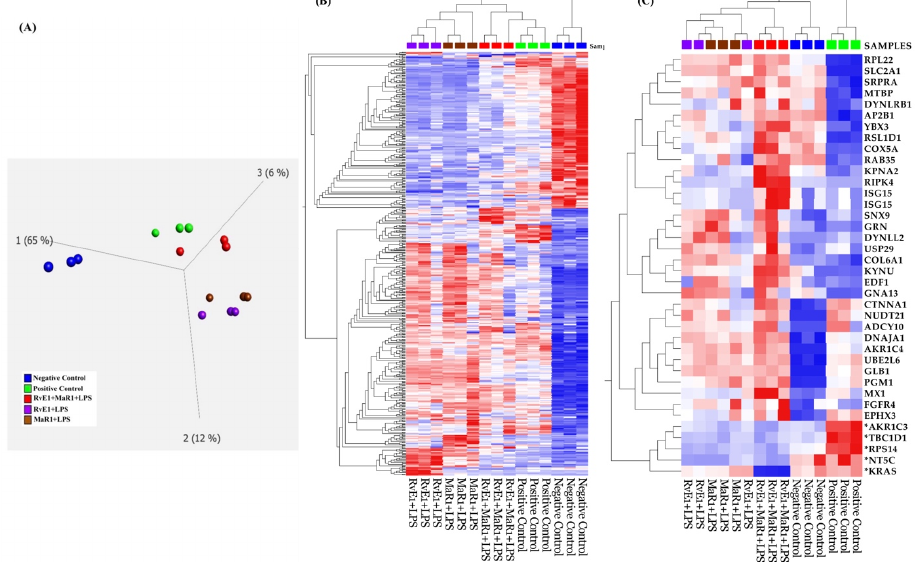
Figure 9. ( A ) Principal components analysis using the expression dataset of 464 differentially ex- pressed proteins between Negative control, Positive control, RvE1 + LPS, MaR1 + LPS, and RvE1+ MaR1 + LPS. ( B ) Hierarchical cluster analysis using the expression dataset of the 464 differentially expressed proteins as described above. ( C ) Hierarchical cluster analysis using the expression dataset of 33 anti-inflammatory and 5 pro-inflammatory proteins with their expression changes. The heat maps show the expression changes of these proteins among the five sample groups. The figures were partly generated using Qlucore Omics Explorer version 3.7 (Lund, Sweden).